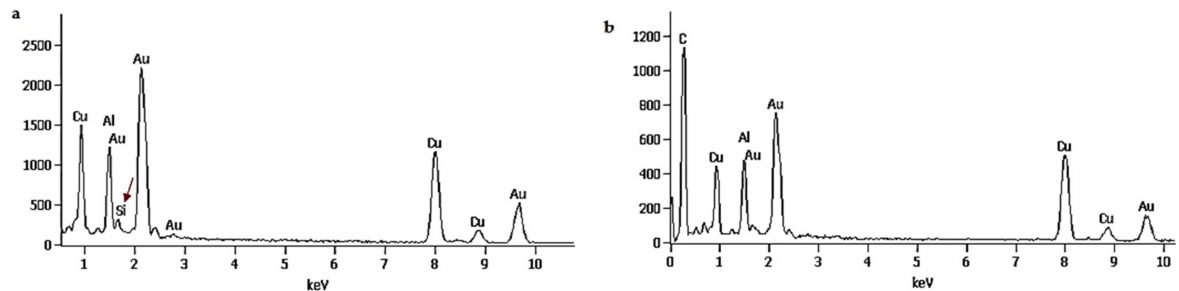
Figure 7. EDAX study of GNPs biofabricated by the whole biomass of N. shiloi, showing the presence of silica with biogenic GNPs ( a ). EDAX study of GNP produced by extracted fucoxanthin from N. shiloi, showing only Au signals and confirmed the absence of silica particle ( b ).